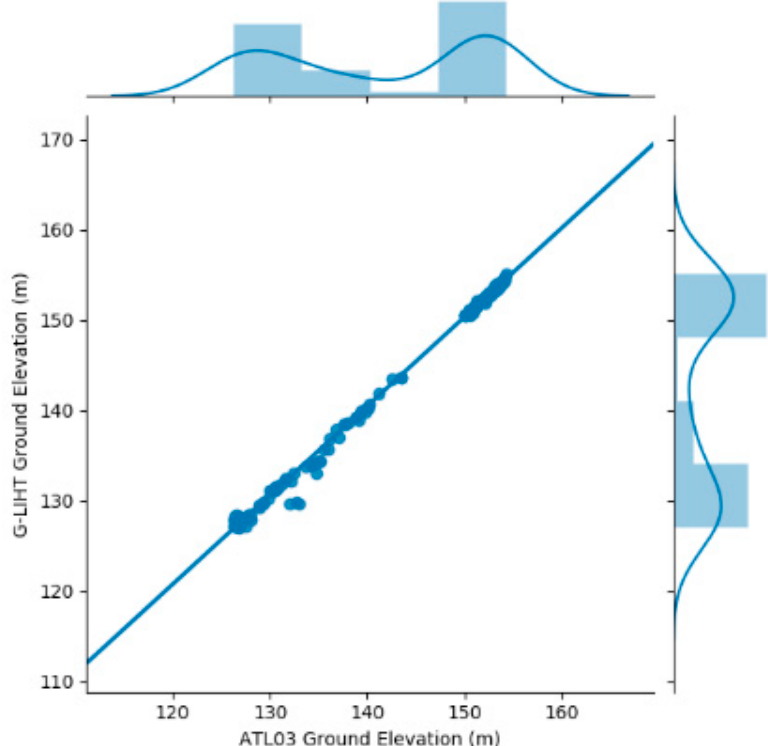
Figure 8. Scatterplot of ATL03 (gt3l) ground topography compared to G-LiHT DTM.